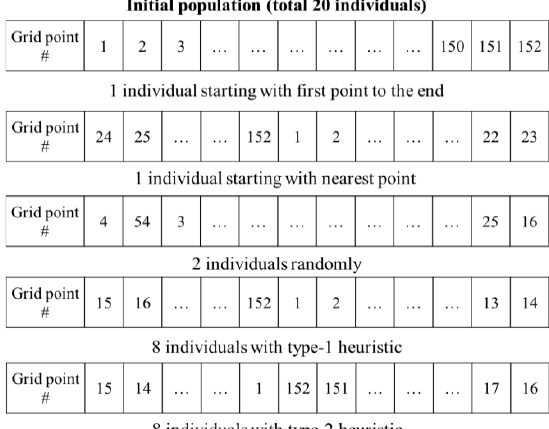
Figure 4. Sample initial population.